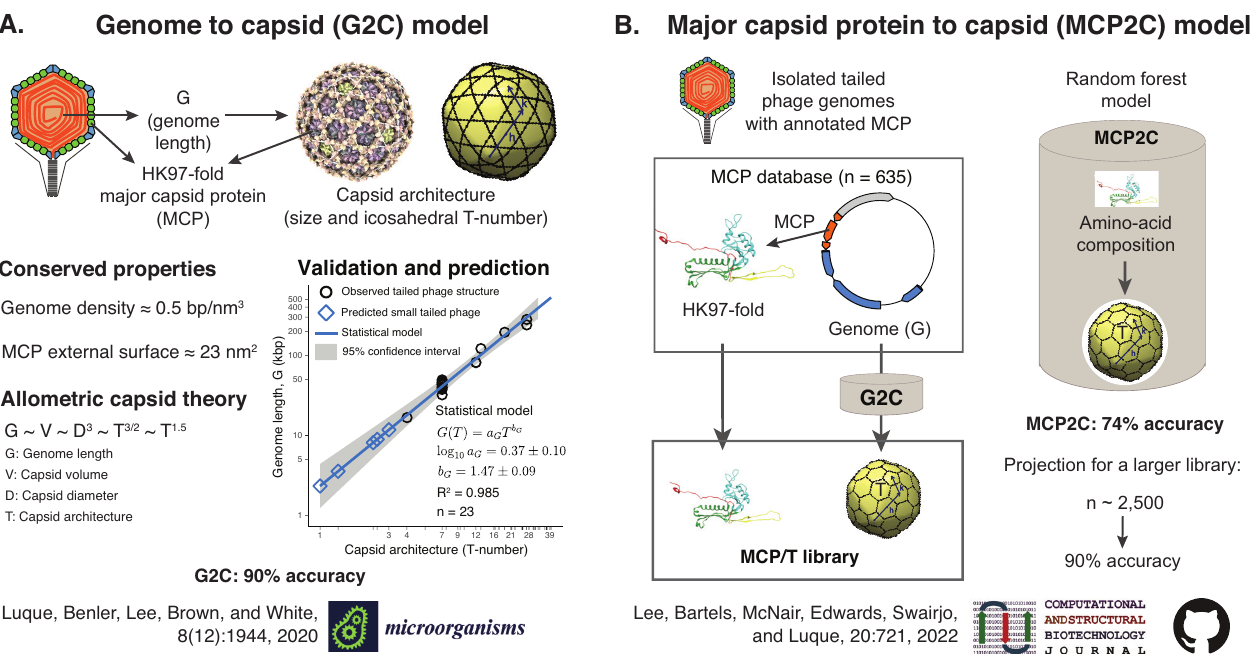
Figure 8. Models predicting capsid architecture. ( A ) The genome to capsid (G2C) model relies on the conserved properties of tailed bacteriophages. The model uses the genome length to predict the capsid architecture (diameter and icosahedral T-number). ( B ) The major capsid protein to